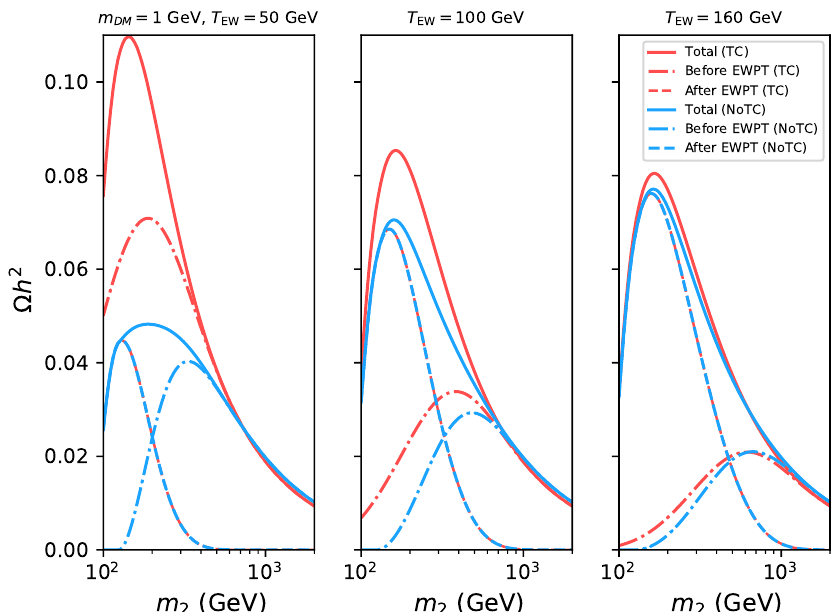
Figure 2 . DM Relic density (cid:10) h 2 as a function of m 2 , for m 1 = 1 GeV, y 50 GeV (left panel), T EW = 100 GeV (middle panel), T EW = 160 GeV (right panel). Red lines show the value of (cid:10) h 2 from DM production including thermal corrections: before the EW Phase Transition (EWPT, dot-dashed line), after the EWPT (dashed line), and the total amount (solid line). Light-blue lines show the corresponding value of (cid:10) h 2 disregarding thermal corrections: from DM production before the EWPT (dot-dashed), after the EWPT (dashed), and total (solid).